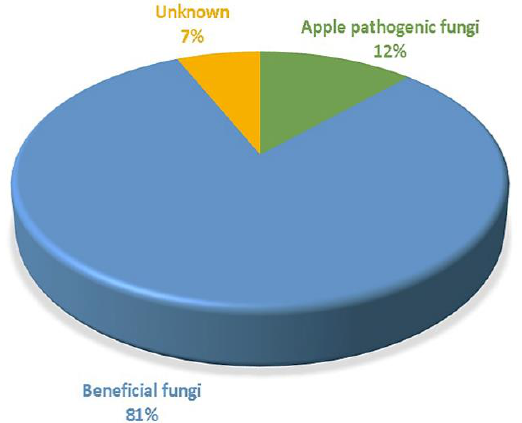
Figure 9. Relative abundance (%RA) at the genus level of fungal traits of apple-inhabiting fungi associated with bagged fruit. Fungal property: apple pathogenic fungi (AP), beneficial fungi (BF), unknown (U).